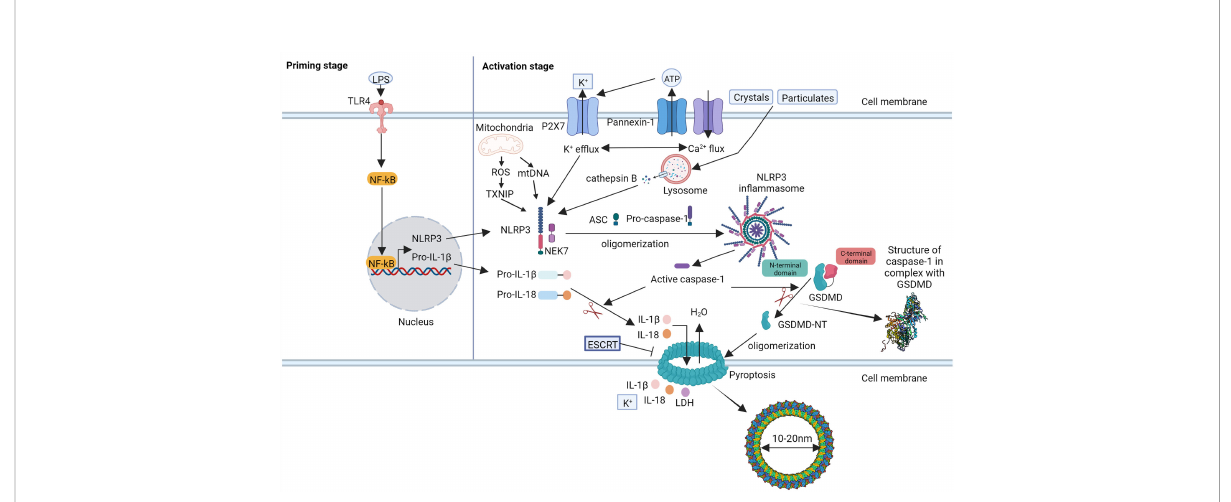
FIGURE 1 The molecular mechanism of canonical pyroptosis pathway mediated by NLRP3 in fl